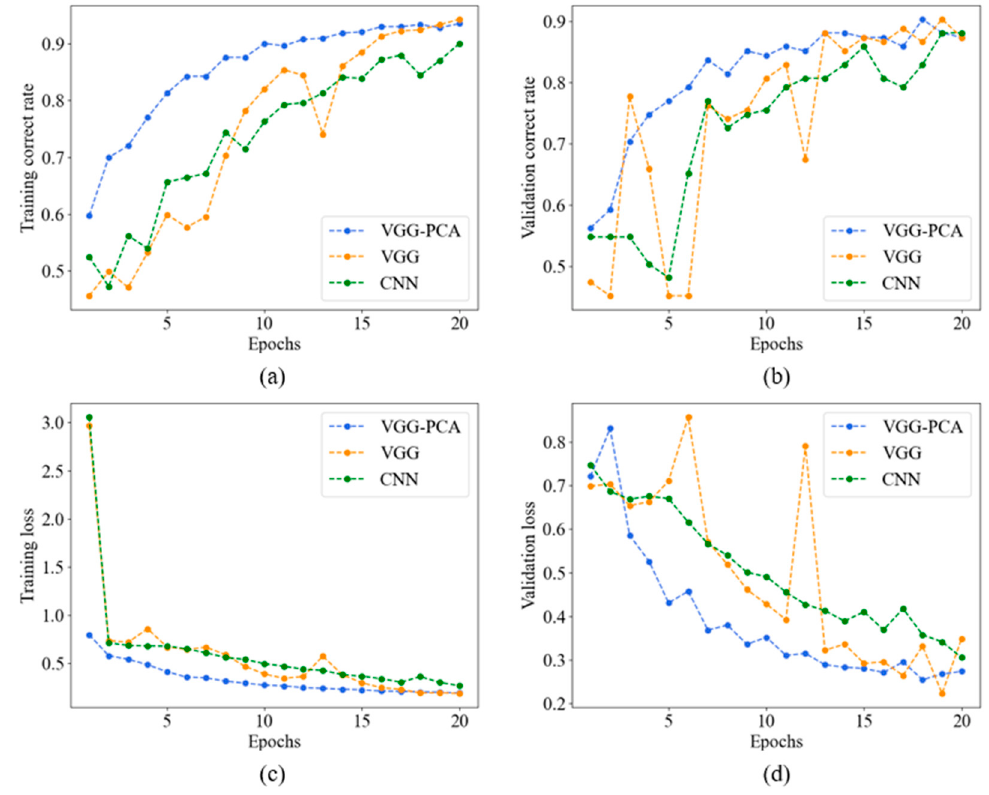
Figure 6. Training and verification results of three models. ( a ) Training CR, ( b ) validation CR, ( c ) training loss, ( d ) validation loss.